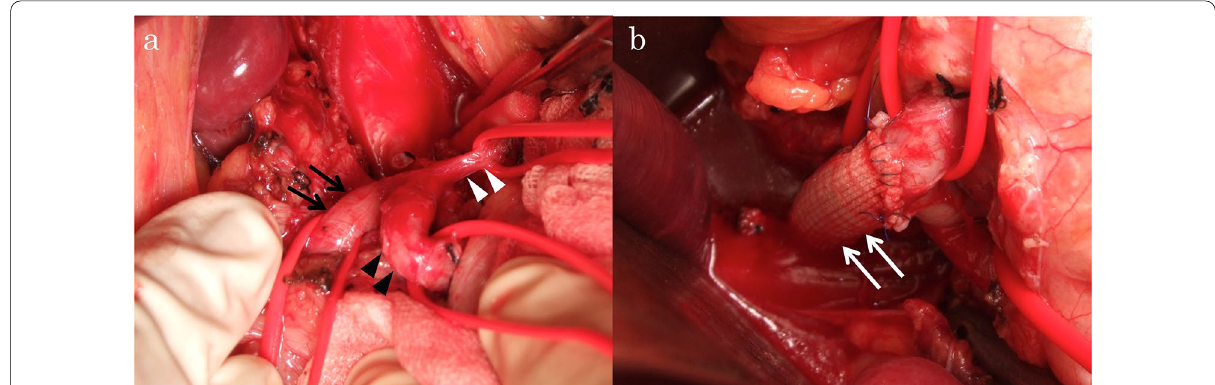
Fig. 2 Intraoperative findings of Case 1. a After release of the median arcuate ligament, the blood flow of the celiac axis (white arrowhead) was not restored. The blood supply of the common hepatic artery (black arrow) and splenic artery (black arrowheads) arose from retrograde blood flow. b Aortosplenic bypass (white arrow) was performed